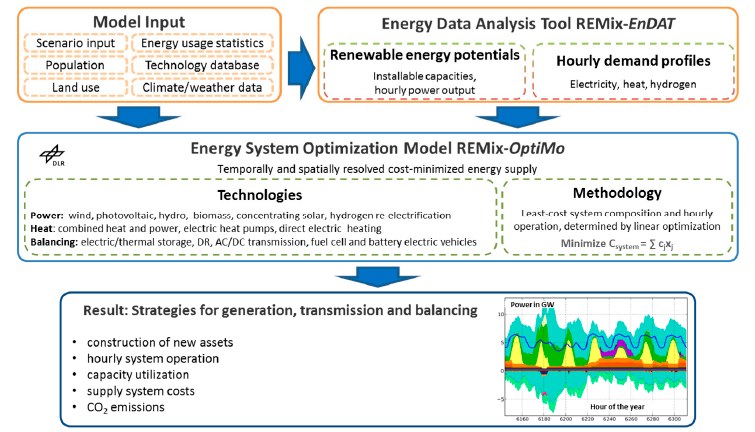
Figure 3. Overview of the REMix model for energy system optimization. Source: [3432] .